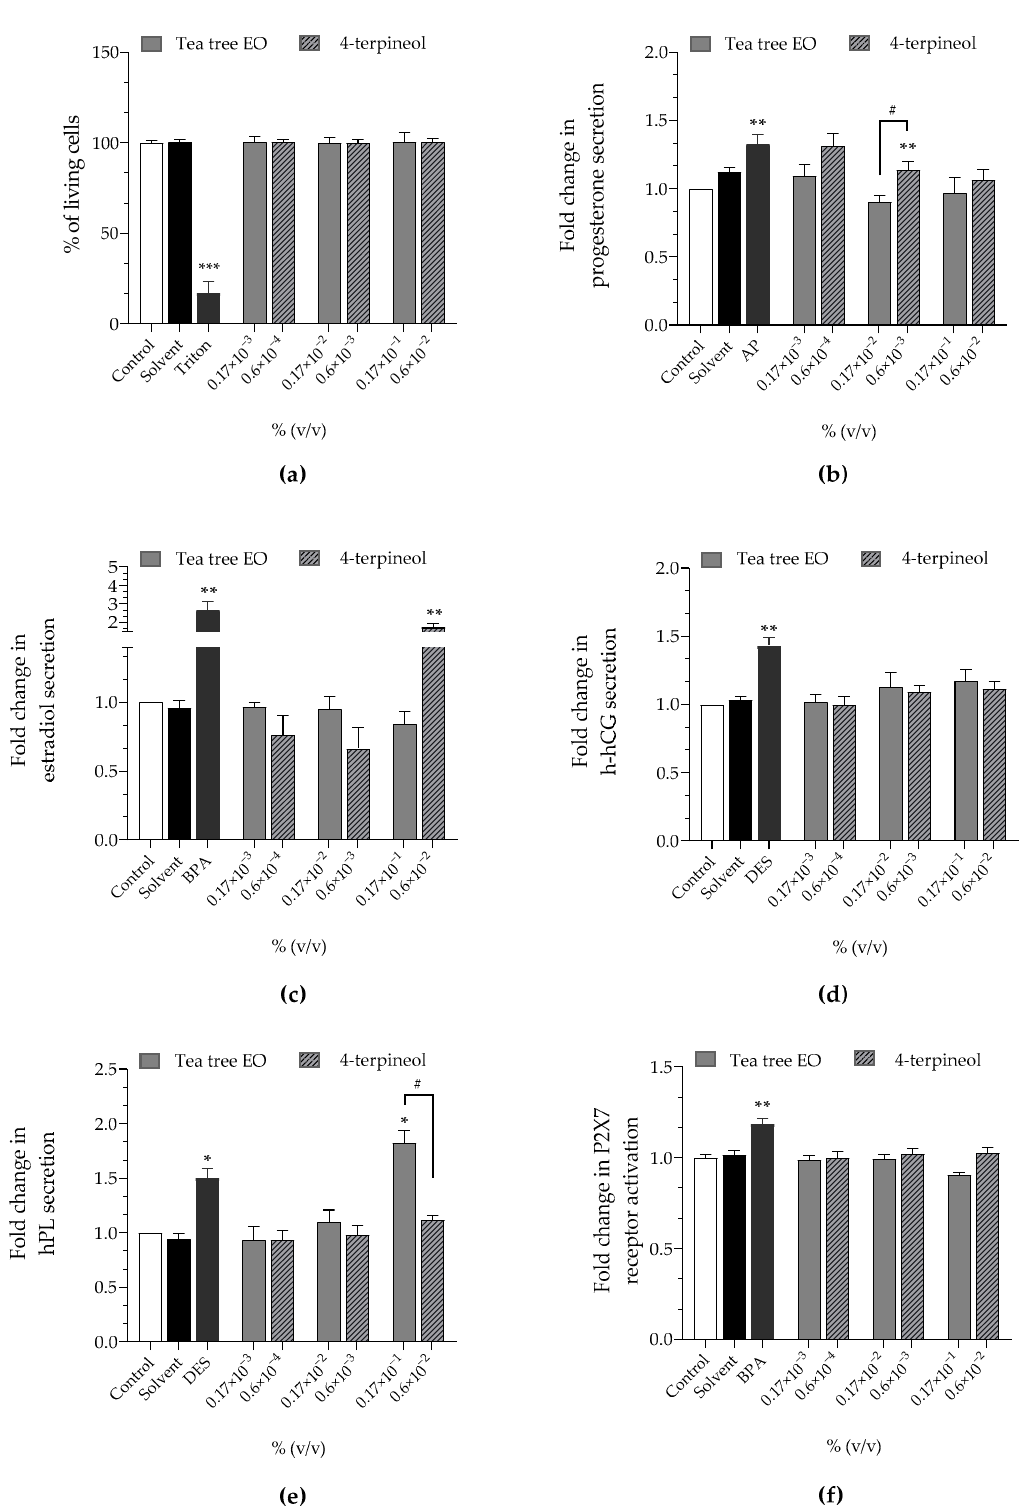
Figure 3. Effects of tea tree EO and 4-terpineol on ( a ) cell viability (Alamar Blue assay), on released hormones: ( b ) progesterone ( c ) estradiol, ( d ) h-hCG, ( e ) hPL and on ( f ) P2X7 receptor activation (YO-PRO-1 assay) were evaluated, after incubation of JEG-Tox cells for 72 h. Triton ® X-100 at 0.016%, bisphenol A (BPA) at 20 µ M, 4-tert-amylphenol (AP) at 10 µ M and diethylstilbestrol (DES) at 3.75 µ M are used as positive controls. The significance thresholds were * p < 0.1, ** p < 0.01, *** p < 0.001 and # p <0.1.